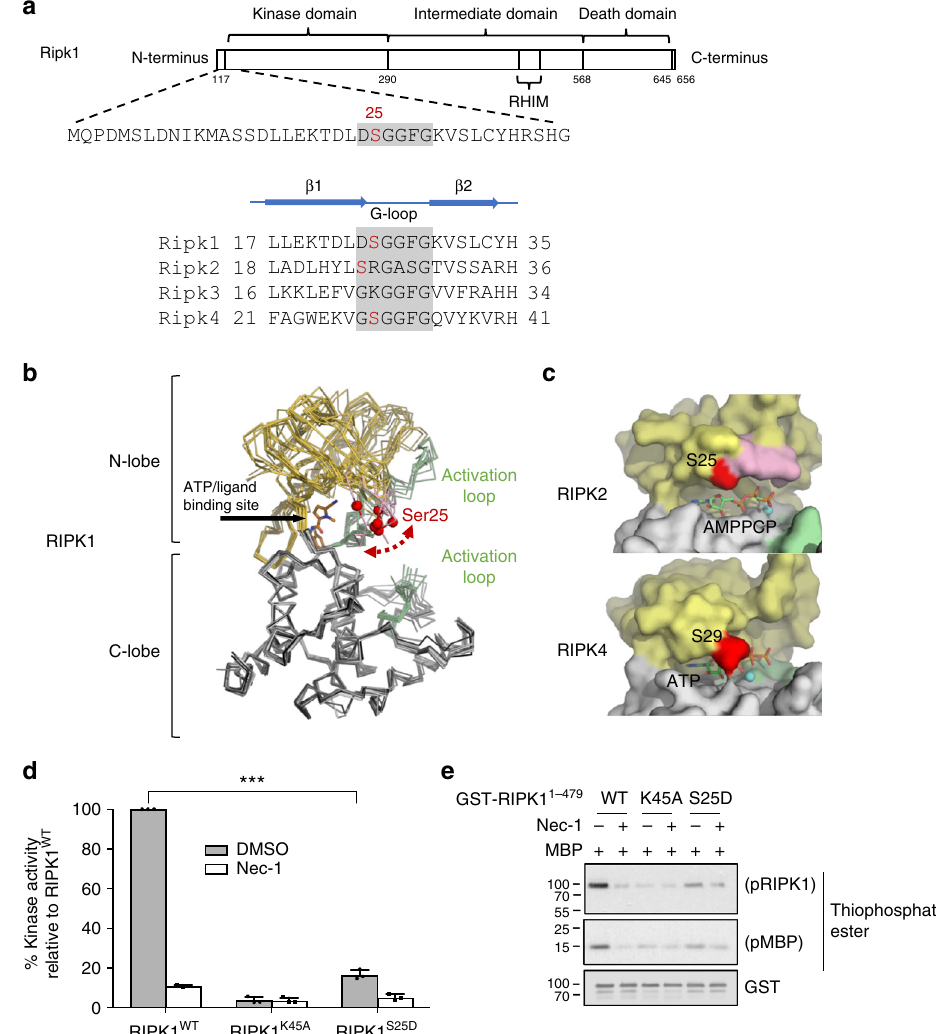
Fig. 6 Phospho-Ser25 directly inhibits RIPK1 catalytic activity. a Schematic representation of mouse RIPK1 primary structure and excerpts from structure- based sequence alignments for murine RIPK1 – 4 (Uniprot sequences Q60855, P58801, Q9QZL0, Q9ERK0) focusing on the region of Ser25. b Ser25 localizes in the fl exible Glycine-rich loop covering the RIPK1 nucleotide binding site. Structural overlays were carried out with respect to the C-lobe of RIPK1 in complex with necrostatin-4 (pdb entry 4ITJ) and employed all available RIPK1 kinase domain structures (pdb entries 4ITH, 4ITI, 4NEU, 5HX6, 5TX5, 4M66, 4M69). The red spheres correspond to the C-alpha positions of Ser25 in the different structures. The structurally ordered parts the activation loop are drawn in green. The intervening portion of the activation loop is disordered in all crystal structures of RIPK1 to date. c Structures of human RIPK2 in complex with the non-hydrolyzable ATP analog AMP-PCP and RIPK4 in complex with ATP. d , e In vitro kinase assays using recombinant truncated RIPK1 mutants (AA 1 – 479). d Quantitative kinase activity measured by ATP consumption using the ADP-Glo kinase assay. Results are presented as a percentage relative to the kinase activity in the wild-type protein and is the mean ± SEM of three independent kinase assays ( n = 3). e Qualitative kinase activity monitored by immunoblot and revealing RIPK1 autophosphorylation and RIPK1-mediated phosphorylation of national and European animal regulations. Animal protocols were approved by week-old mice. This was done by sacri fi cing the mice and subsequently cutting of the ethical committee of Ghent University (EC2017 – 071, EC2017 – 079). part of the ear. This piece was then washed in 70% ethanol and the dermis was removed from the ear with forceps. Both the dermis and the leftover part of the ear were then plated in a six-well plate and covered with a sterile microscopy glass Cell lines . Mouse embryonic fi broblasts (MEFs) and mouse dermal fi broblasts cover. When the cells reached con fl uence (after ~7 days) the cells were passaged and transfected with SV-40 for immortalization. Bone marrow-derived macro- (MDFs) were cultured in Dulbecco ’ s modi fi ed Eagle ’ s medium supplemented with phages (BMDMs) were isolated by fl ushing the femurs and tibias of 7 – 10-week-old 10% fetal calf serum, L-glutamine (200 mM) and sodium pyruvate (400mM) in mice with cold PBS using a 26G needle. The cell suspension was fi ltered normoxic conditions (5% CO 2 ). When the cells were still at the primary state, 0.1% β -mercaptoethanol and penicillin (100IU/ml) and streptomycin (0.1 mg/ml) was through a 70 μm cell strainer, centrifuged at 220 × g , and treated with ACK lysis buffer to remove red blood cells. After centrifugation, the cells were resus- added to the medium. Primary Ripk1 + / + , Ripk1 + /S25D , and Ripk1 S25D/S25D MEFs pended in RPMI medium supplemented with 10% FCS, 2mM L-Glutamate, were isolated from E12.5 littermate embryos following standard protocol and 0.1% β -mercaptoethanol, penicillin (100IU/ml) and streptomycin (0.1 mg/ml), and cultured under low-oxygen conditions (3% O 2 ) 60 . MEFs were subsequently 40 ng/ml mouse M-CSF. The cells were plated in a 10 cm non-cell-culture-treated immortalized by transfection of a SV40 large T-expressing construct with Jet- dish and cultured for 7 days at 37 °C in a 10% CO 2 incubator. The medium was PRIME (Polyplus transfection) according the manufacturer ’ s instructions. Wild- changed on day 3 and 6. On day 7, the differentiated cells were collected by type and Ikk α / β − / − MEFs were a kind gift of Prof. E. Dejardin and were previously scraping in cold PBS, centrifuged at 200 × g , resuspended in medium without described 22,61 . Ripk1 + / + Shpn + / + , Ripk1 + / + Shpn cpdm/cpdm , Ripk1 S25D/S25D growth factor, and seeded for an experiment. Shpn + / + , and Ripk1 S25D/S25D Shpn cpdm/cpdm MDFs were isolated from ears of 8 – 10-